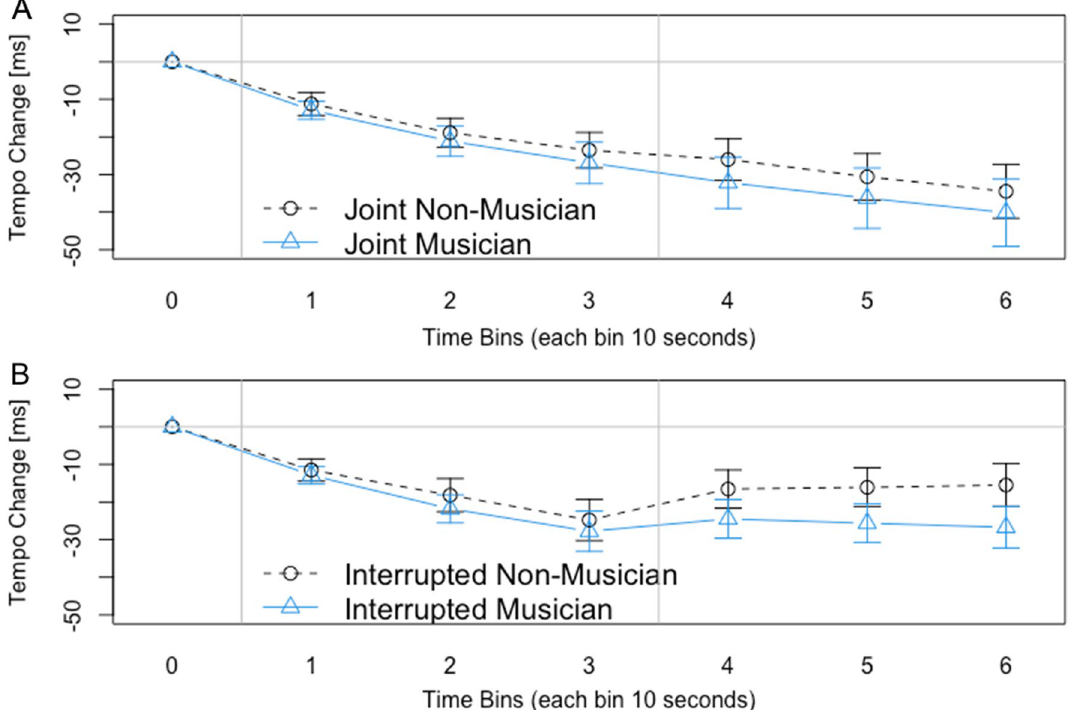
Figure 3. A direct comparison between Musician and Non-Musician data. ( A ) The Tempo Change in the Joint condition which did not differ between Non-Musicians and Musicians. ( B ) The Tempo Change in the Joint Interrupted condition for Non-musicians and Musicians. There was also no significant difference between the two groups in this condition.